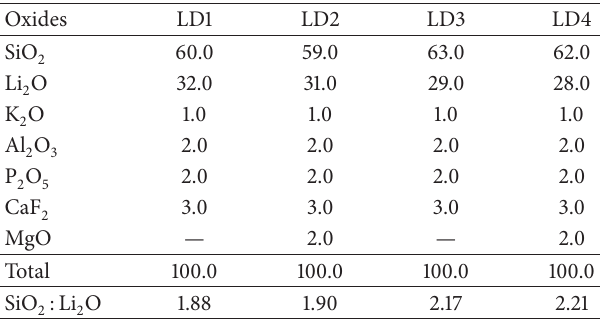
Table 1: Glass compositions (%